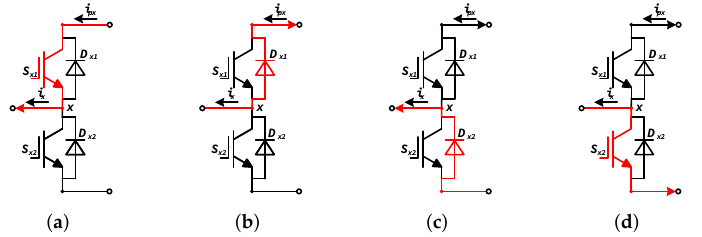
Figure 3. The current paths in a single leg. ( a ) The current flows through S x 1 . ( b ) The current flows through D x 1 . ( c ) The current flows through D x 2 . ( d ) The current flows through S x 2